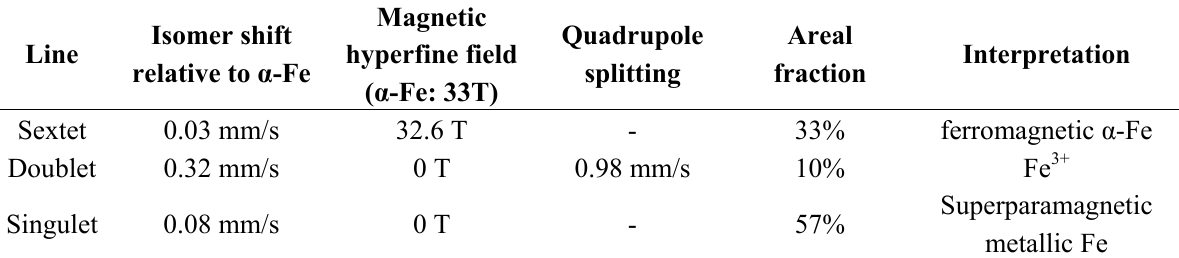
Table 3. Mössbauer data for powder P1.